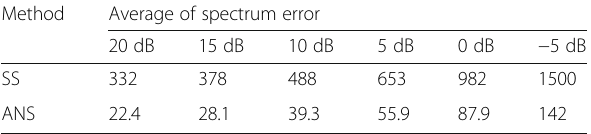
Table 1 Normalized average of spectral subtraction and ANS spectrum errors (RMSE criteria) on test set A of Aurora 2 task